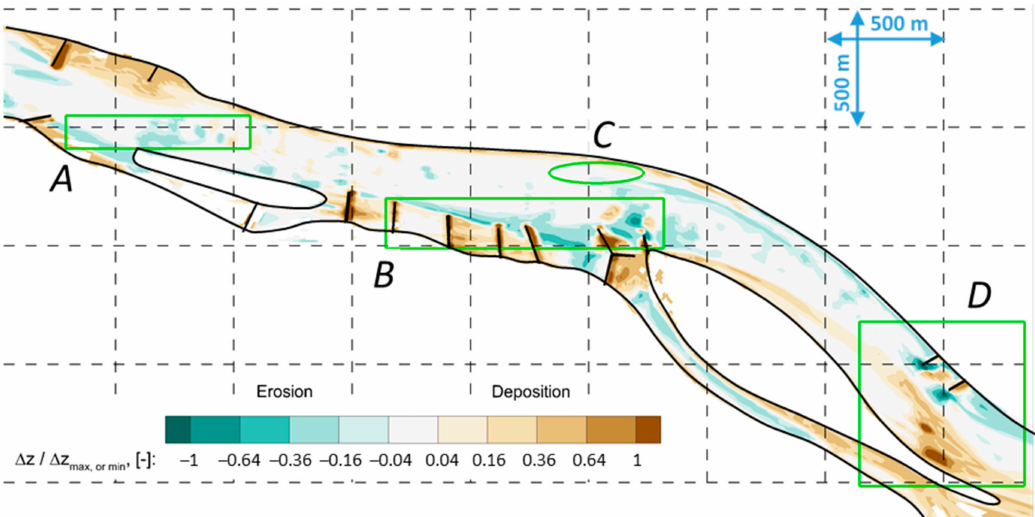
Figure 13. Normalized bed changes of the calculated values. The calculation was elaborated for the eight flood waves in the period October 2012–October 2014 (Figure